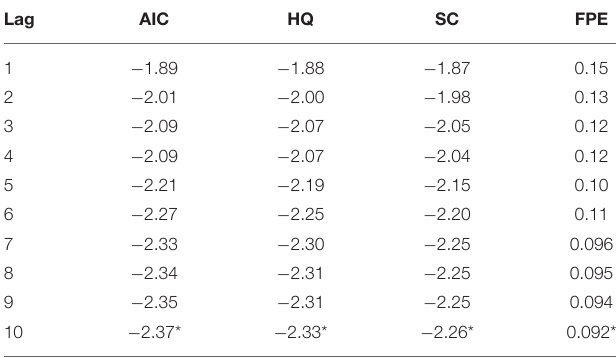
TABLE 1 | Results of the COVID and PKUSD using ADF test. Variable Levels